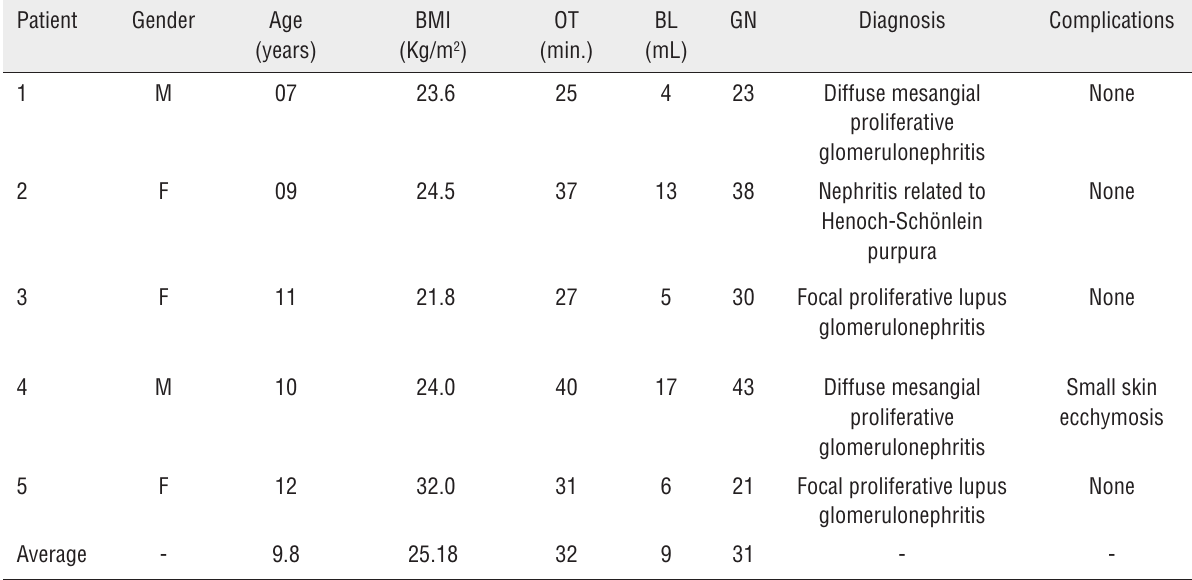
Table 1 - Clinical features of patients submitted to Single-port retroperitoneal renal biopsy.